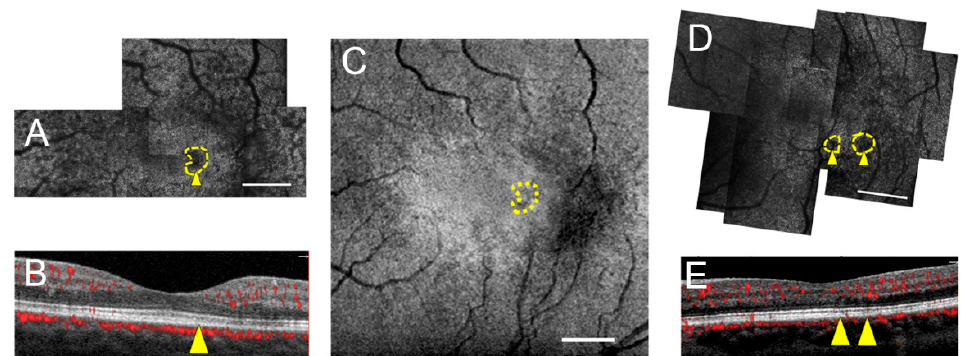
Figure 3. Three photoreceptor lesions correspond to both intact ellipsoid zone (EZ) and interdigitation zone (IZ) on spectral ‐ domain OCT (SD ‐ OCT) in two stage 0 MacTel eyes. Subjects 1 (left eye; A – C ) and 3 (left eye; D , E ). AOSLO montages with outlined, yellow lesion and yellow arrowhead ( A , D ) corresponding to accompanying normal SD ‐ OCT cross ‐ sections ( B , E ). ( C ) En ‐ face structural OCT of the EZ with yellow outline of lesion identified on AOSLO in ( A ) reveals seemingly unremarkable structural appearance on OCT. Scale bars = 500 μ m.